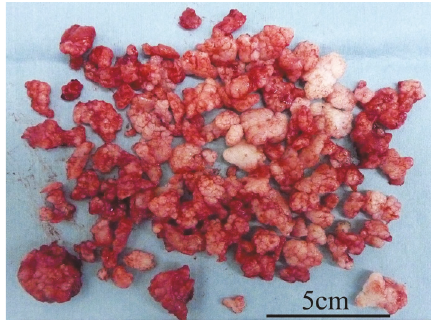
Figure 5: Excised osteochondromas.